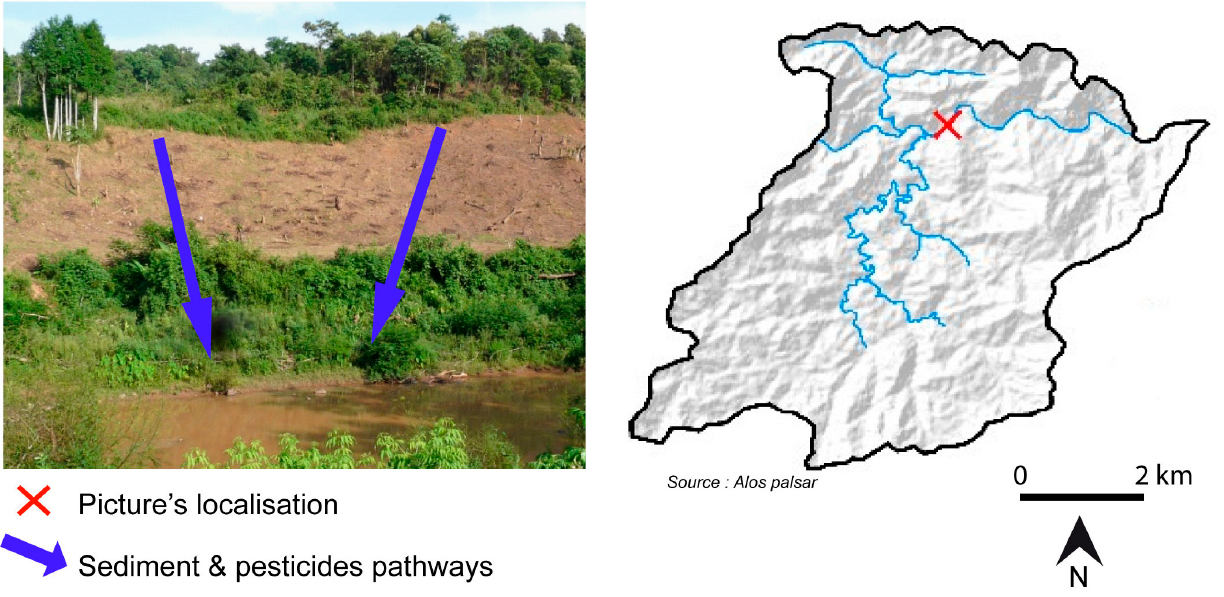
Figure 6. Example of an effective connection between an upland plot and the river through a steep slope covered by a riparian forest (Houaylack-Vangven, 2017) and location map of the observation.